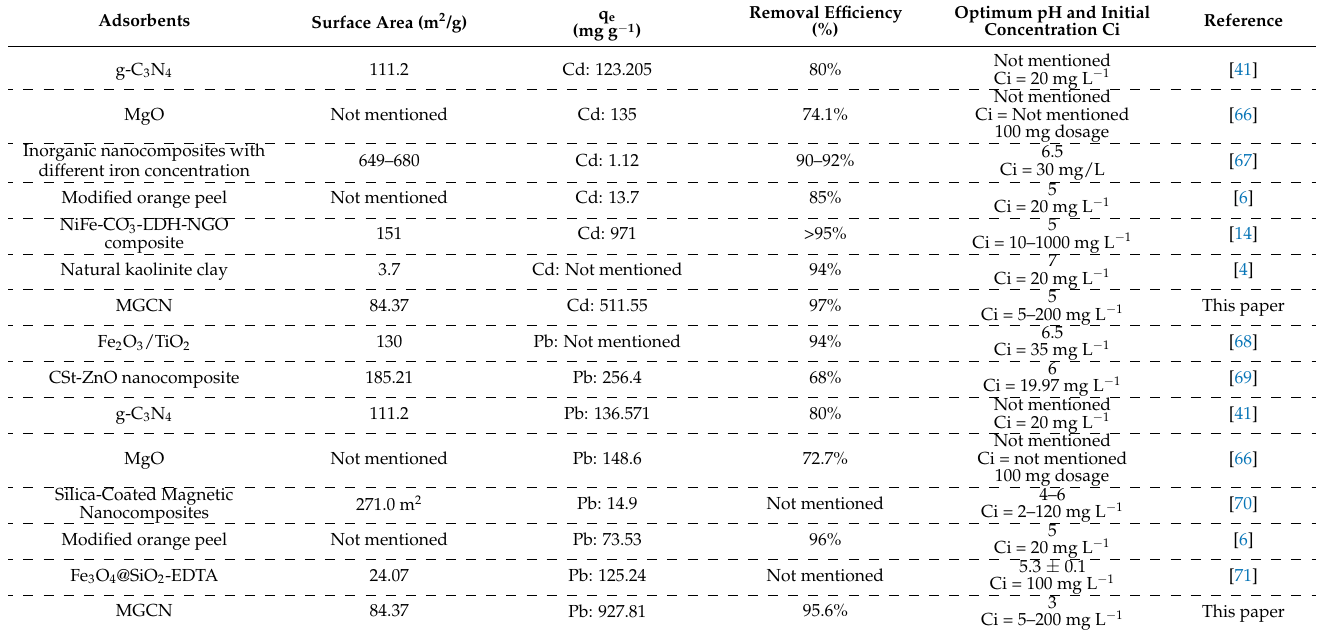
Table 5. Adsorption characteristics of MGCN and other nanosorbents for the removal of Pb ++ and Cd ++